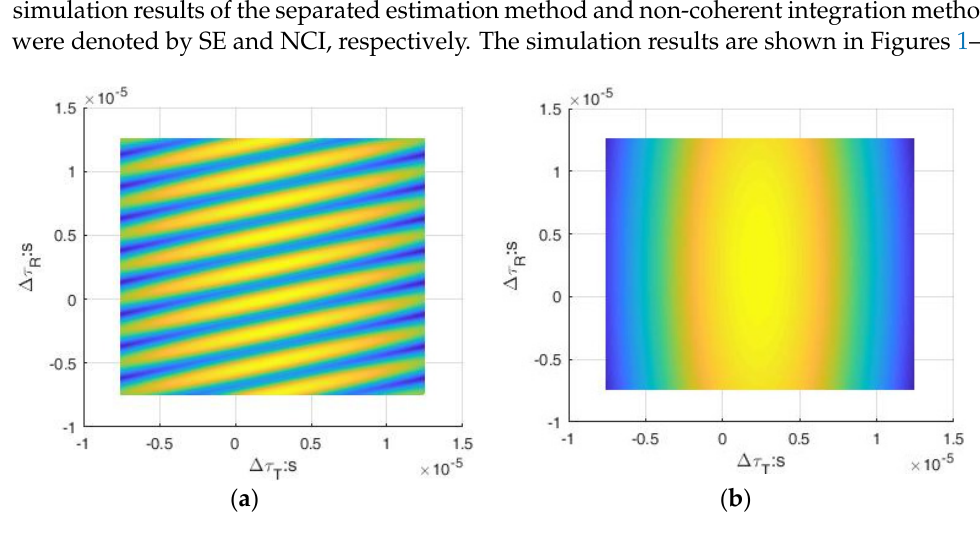
( b ) Figure 2. Normalized cross correlation comparison of coherent integration and separate process at SNR = 20 dB. ( a ) Reference signal cross correlation. ( b ) Target signal cross correlation. ( a ) ( b ) Figure 3. Estimation error accumulation probability curves of the three methods at SNR = 20 dB. ( a ) System time synchronization error estimation. ( b ) Target TDOA estimation.